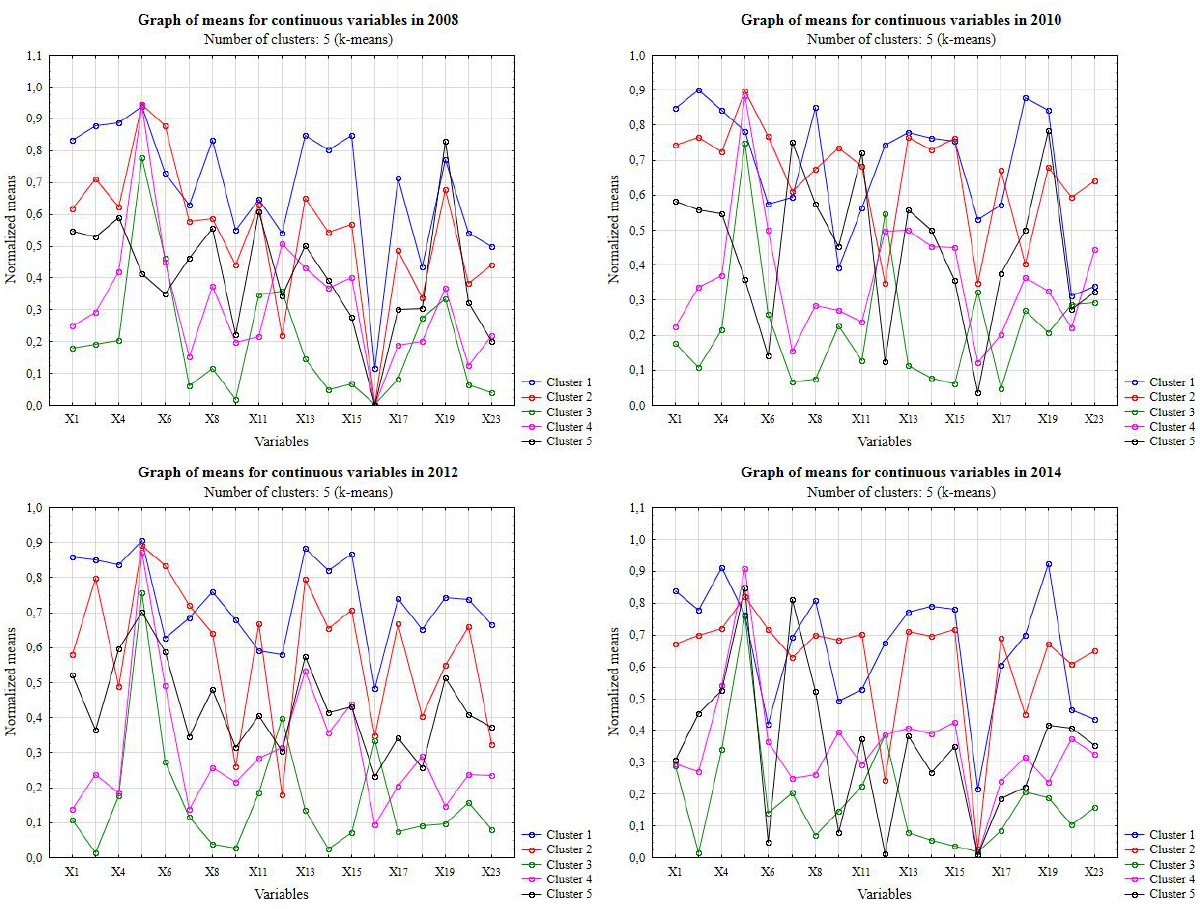
Figure 4: Graphs of means for variables in 2008, 2010, 2012 and